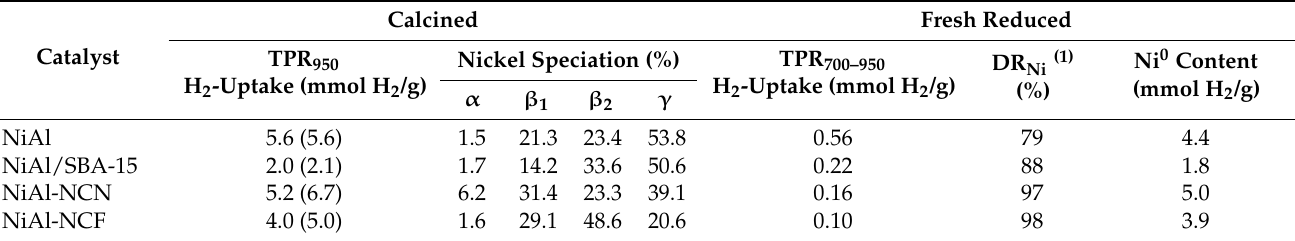
Table 2. Results of H 2 -TPR for NiAl/SBA-15 and nanocasted solids. Calcined Fresh Catalyst